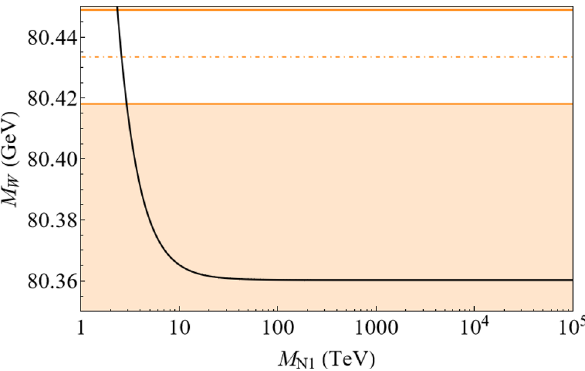
Figure 9 . Predictions for the W gauge boson mass as a function of the lightest heavy neutral lepton mass M N 1 . The best fit value (dotted-dashed line) as reported in eq. (6.1), and the corresponding 90% C.L. (shaded area) experimental limits are